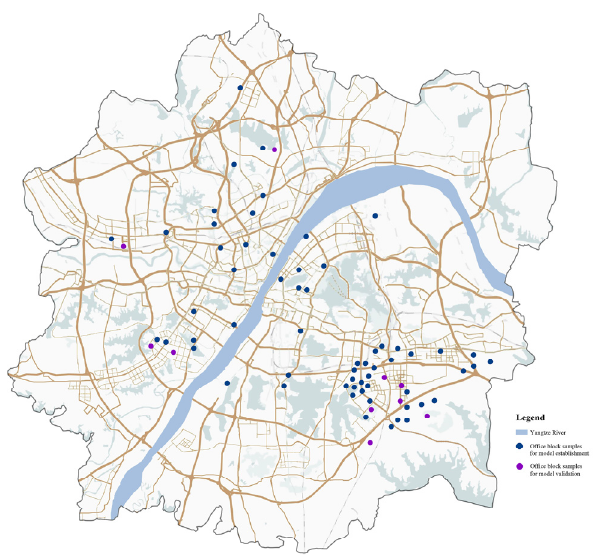
Figure 5. The distribution of office block samples.